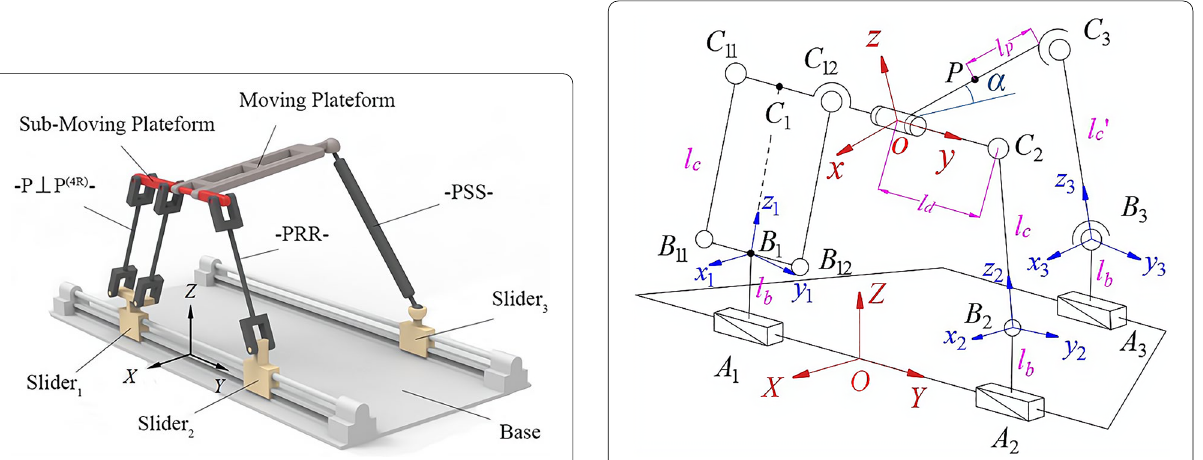
Figure 1 3D model of the 2T1R PM Figure 2 Schematic diagram of 2T1R